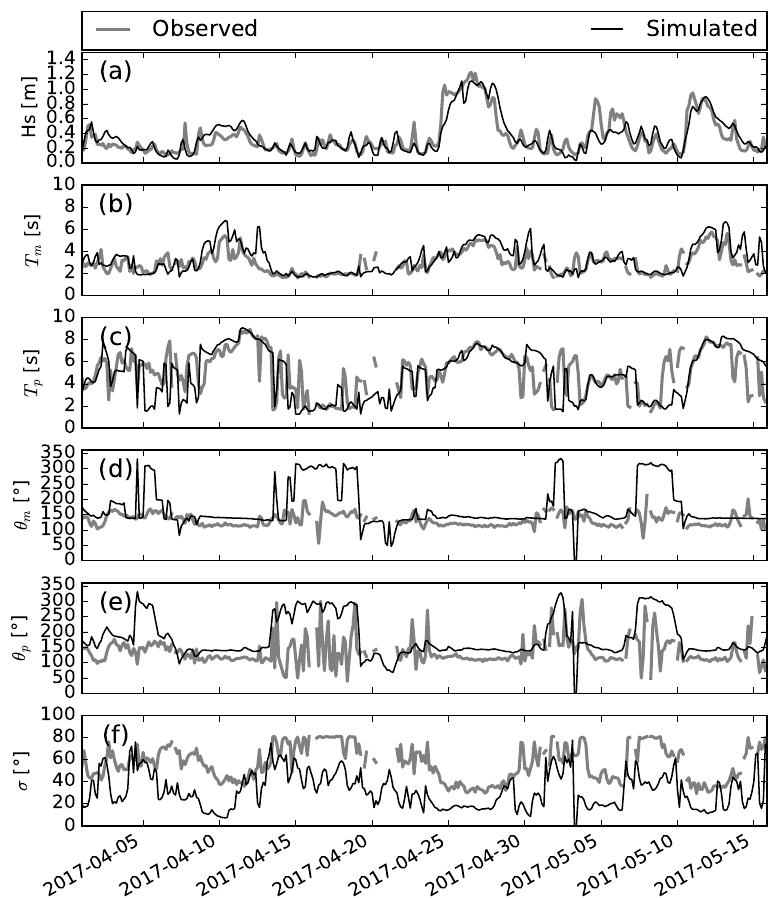
Figure 8. Comparisons between measurements and predictions of spectral bulk wave parameters at Poetto beach. H s : significant wave height ( a ); T m : mean period ( b ); T p : peak period ( c ); θ m : mean wave direction ( d ); θ p : peak wave direction ( e ); σ : wave directional spread ( f